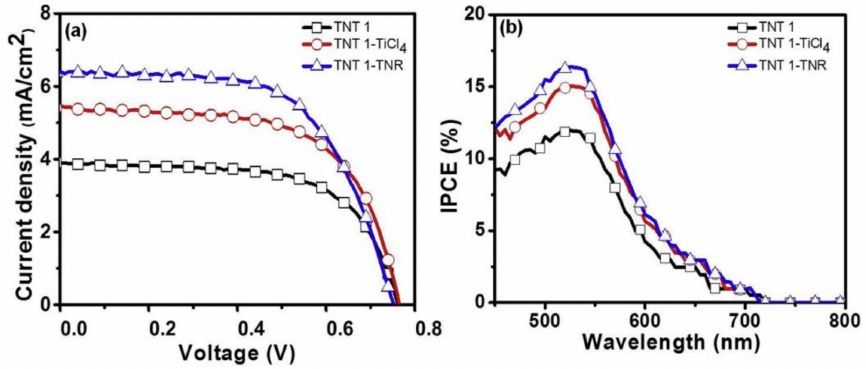
Figure 14. ( a ) Current-voltage curves; and ( b ) IPCE curves of fabricated DSSCs by using TNTs before and after TiCl 4 treatment and TiO 2 nanorods decoration as photoanodes. Reprinted with the permission from reference